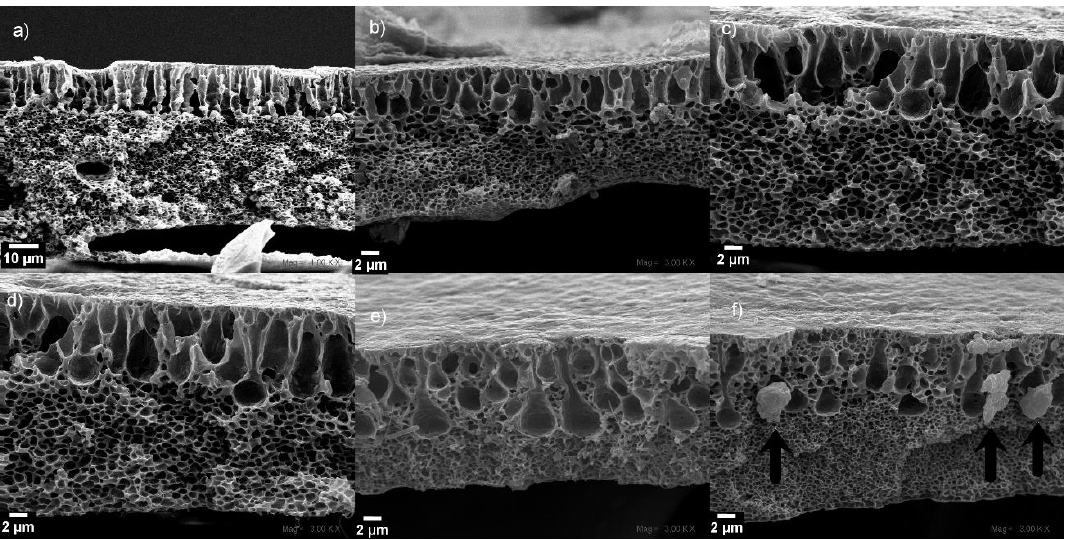
Figure 5. Cross-section SEM micrographs of the PVDF-NWPET samples: ( a ) neat PVDF-NWPET and ( b – f ) doped with 2, 4, 6, 8, 10% CuONPs, respectively. The scale bars represent 2 µ m, except for ( a ) (0%), which is 10 m.